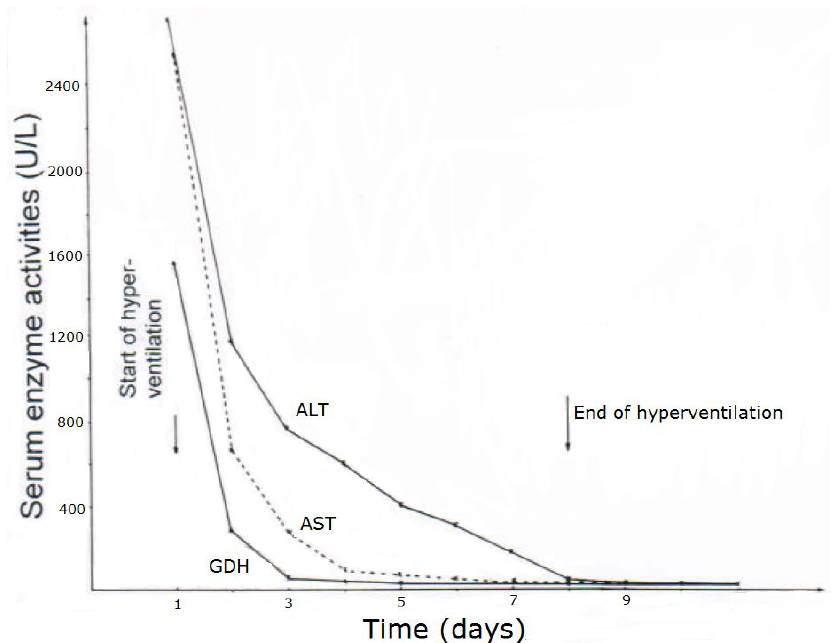
Figure 3. Patient 12 with CCl 4 intoxication by inhalation (unknown amounts). Serum activities of ALT, AST, and GDH after intoxication and during CO 2 -induced hyperventilation therapy. Abbreviations: ALT, Alanine aminotransferase; AST, Aspartate aminotransferase; GDH, Glutamate dehydrogenase.